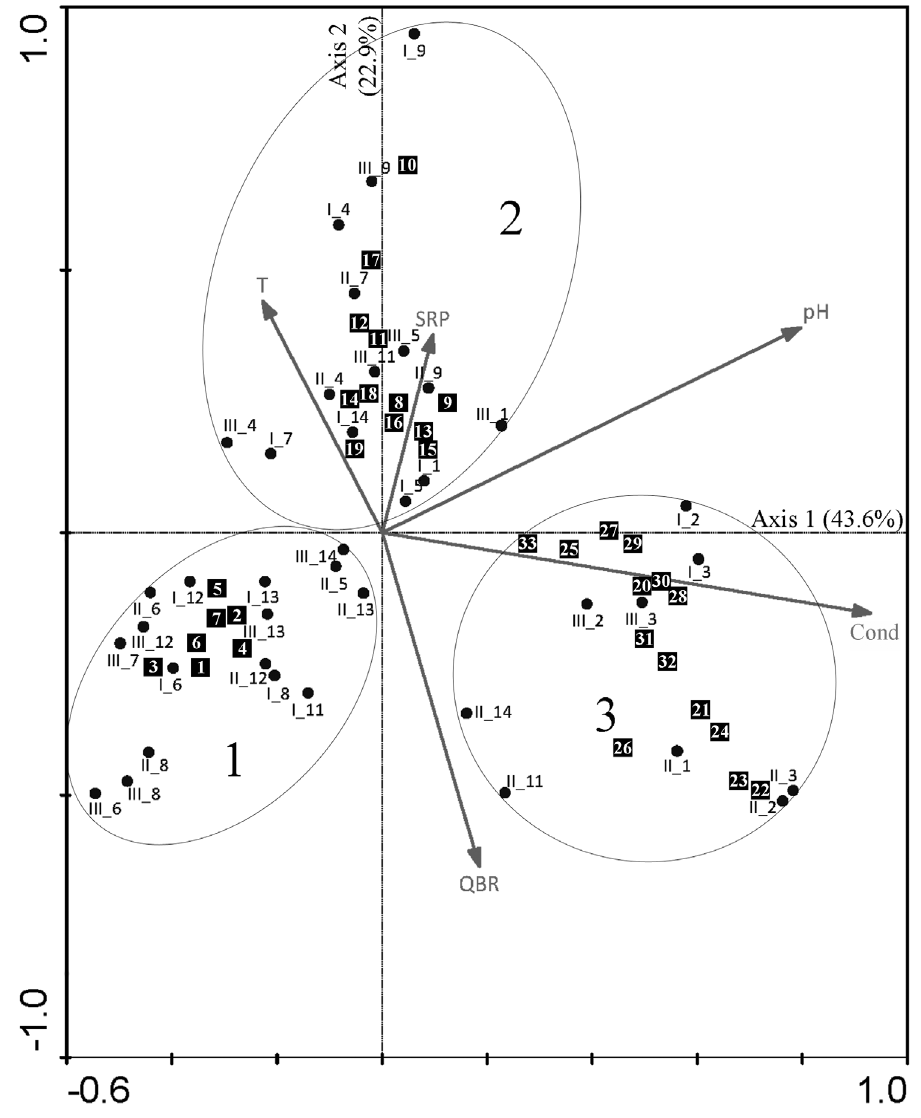
Figure 145. Canonical Correspondence Analysis (CCA) ordination plot. Distribution of sampling sites based on diatom abundance data in relation to statistically significant environmental variables. Three groups of samples are depicted within ovals. For visualization purposes, only species with significant IndVals ( p < 0.05) are included in the plot. Black squares correspond to species; numbers within the black squares refer to taxa names in Table 4. Sampling sites are codified as follows: a Roman numeral indicating the sampling campaign (I, II and III), followed by an underscore symbol and an Arabic numeral indicating the sampling site (sites 1 to 14). For abbreviations and units of the physical and chemical parameters refer to Table